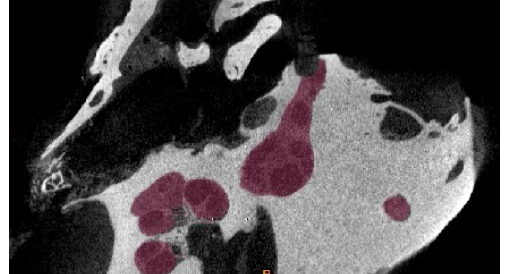
Fig.7. Basilar membrane and measurement.